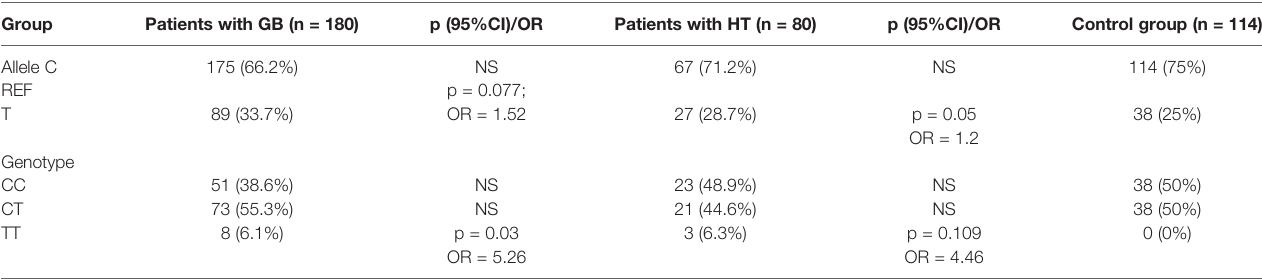
P, p-value; REF., reference. NS, p-value > 0.05. OR, odds ratio. 95% CI, 95% con fi dence interval for odds ratio.